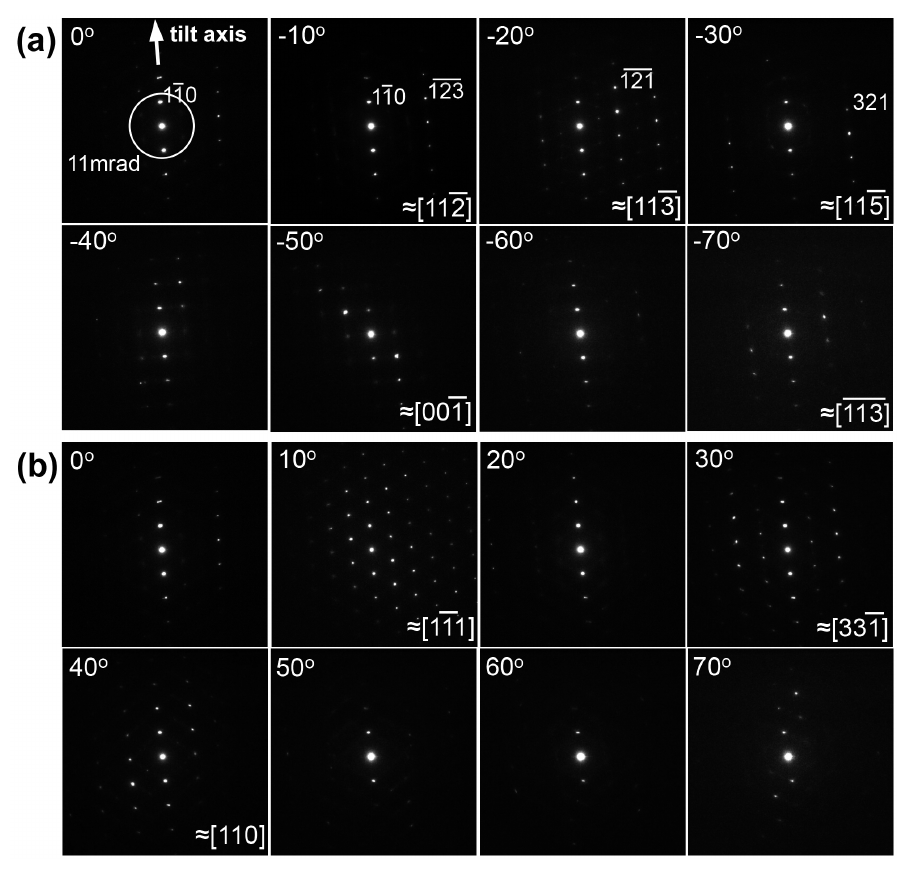
Figure 1. Tilt-series of selected area electron diffraction (SAED) patterns obtained from the β phase region in a Ti–35mass%Nb alloy. The hh 0 systematic reflections are excited parallel to the tilt axis. ( a ) SAED patterns obtained at tilt angles from 0° to − 70°, and ( b ) those from 0° to